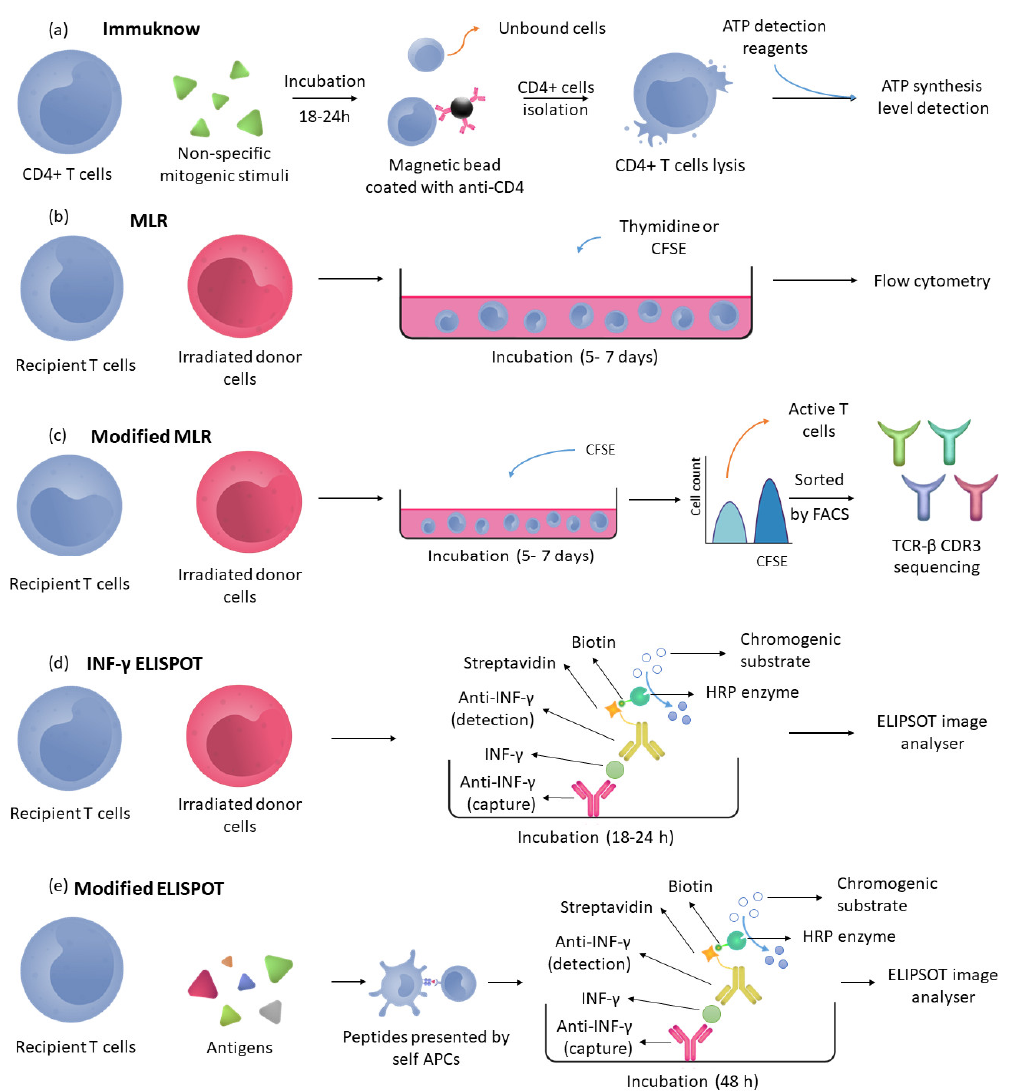
Figure 4. Cellular immunity detection method. ( a ) Immuknow: Recipient’s T cells are incubated with nonspecific mitogens; then, CD4+ T cells are isolated using a magnetic bead coated with anti- CD4 antibodies, and finally, these CD4+ cells are lysed to measure the ATP levels. ( b ) MLR: Recipi- ent’s T cells are incubated with irradiated donor cells and thymidine or CFSE to quantify the cell proliferation by measuring the thymidine or CFSE concentration in cells using flowcytometry. ( c ) Modified MLR follows the same process as the MLR assay, but the cells are incubated only with CFSE to quantify CFSE and isolate CFSE-low cells (active T cells) by fluorescence-activated cell sort- ing (FACS), and finally, the TCR-β CDR3 receptors are sequenced. ( d ) INF-γ ELISPOT: Recipient’s